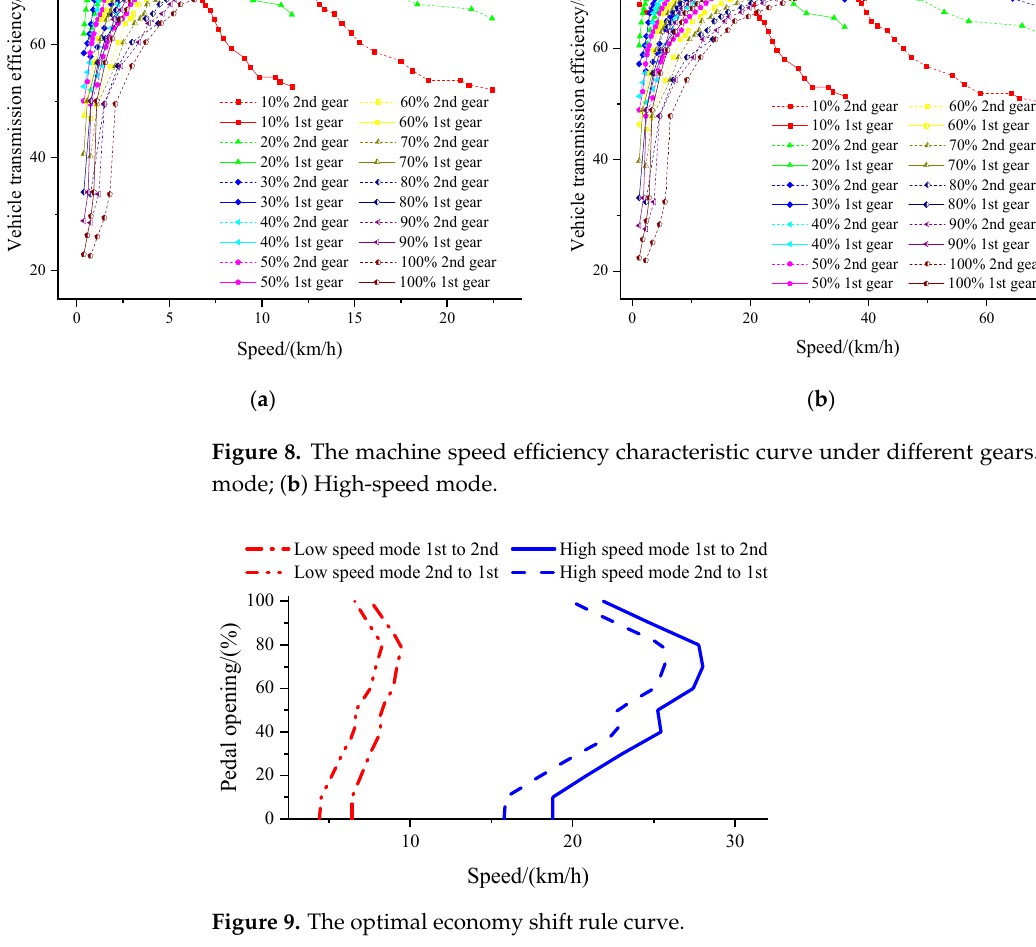
Figure 7. The speed efficiency curve of an electric motor under 10%, 20%, ..., 100% of the accelerator pedal opening. (2) As shown in Figure 7, the machine speed efficiency characteristic curve under differ- ent gears can be obtained, the result of which is shown in Figure 8. If the efficiency curves of two adjacent gears intersect, the intersection point shall be taken as the shift point. If the efficiency curves of two adjacent gears do not intersect, the highest speed point of the efficiency curve of the lower gear shall be taken as the shift point.